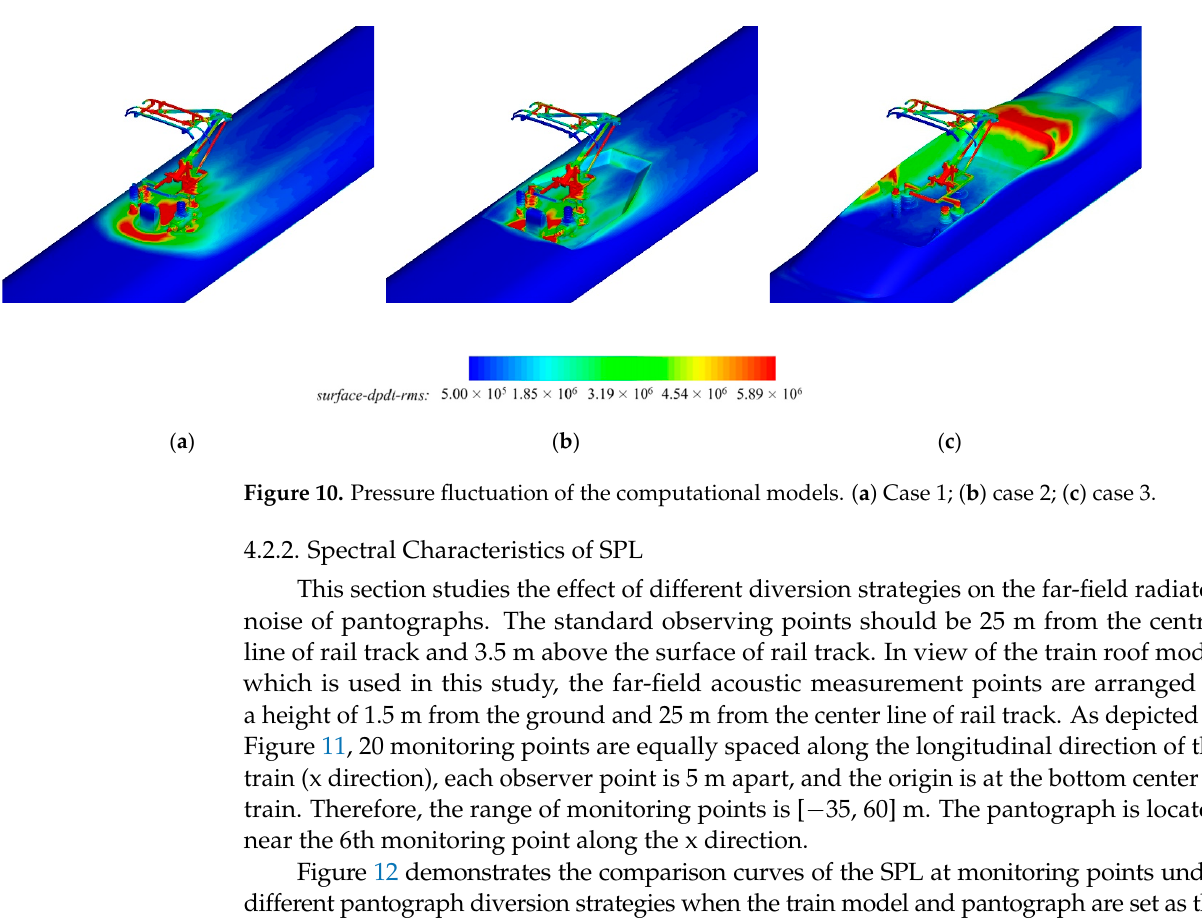
Figure 11. Locations of the standard sound monitoring points along the